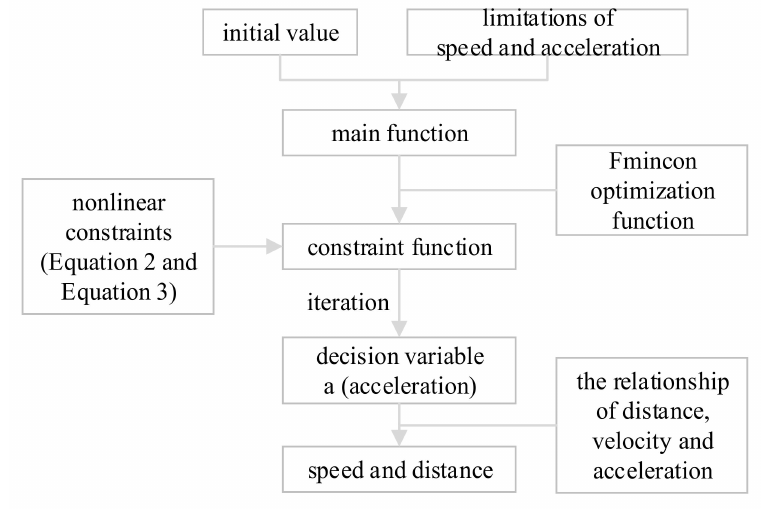
Figure 2. Iterative